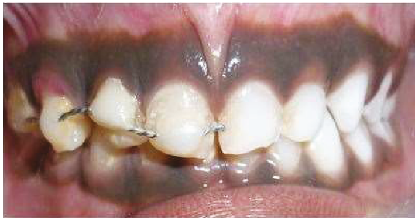
Figure 4: Surgically extruded 53 stabilised using composite